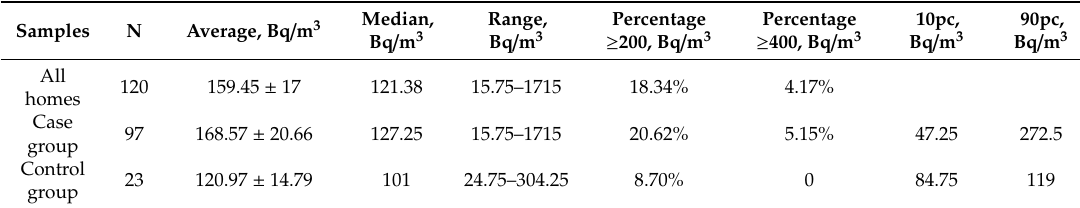
Table 3. The indoor radon for investigated